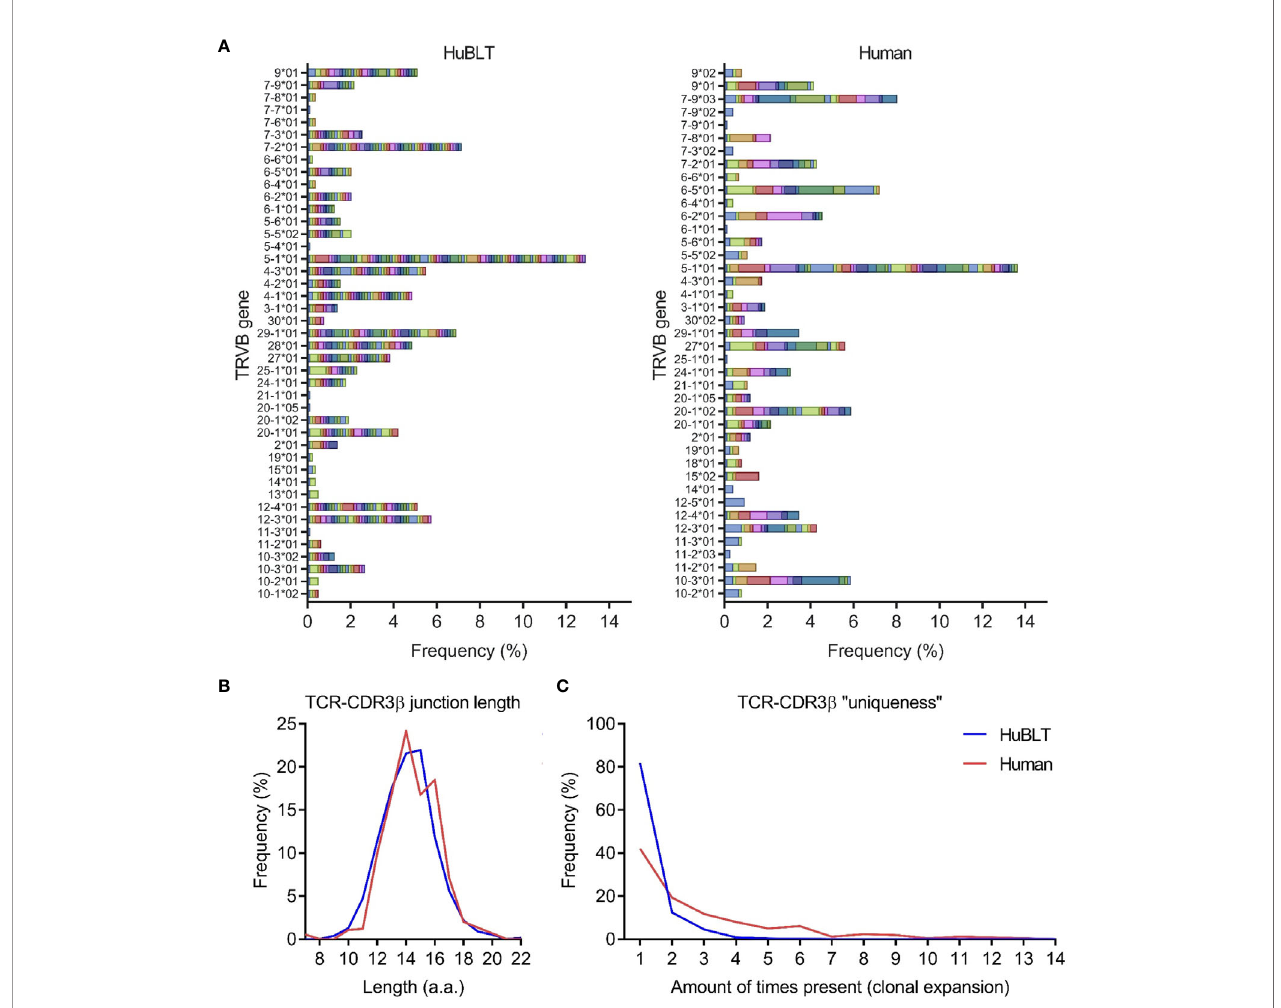
FIGURE 2 | TCR diversity in HuBLT mice is comparable to adult humans. (A) TCR b deep sequencing was performed on leukocytes from a HuBLT mouse spleen and an adult human peripheral blood donor. Deep sequencing reads were analyzed for TRBV gene usage and CDR3 b sequence, amino-acid length, and “ uniqueness ” . The frequency of sequences for HuBLT mouse (left panel) and adult human (right panel) samples grouped by TRBV usage are presented as a histogram (normalized to the total number of sequence reads obtained). Each CDR3 b clone is individually color-coded to visualize clonal expansion. (B, C) A histogram of CDR3 b junction length (in B ) and a histogram of CDR3 b “ uniqueness ” (in C ) of HuBLT mouse (blue) and adult human (red) samples are presented. For each sample, ~800 TCR b transcript reads of ~500 bp in length were